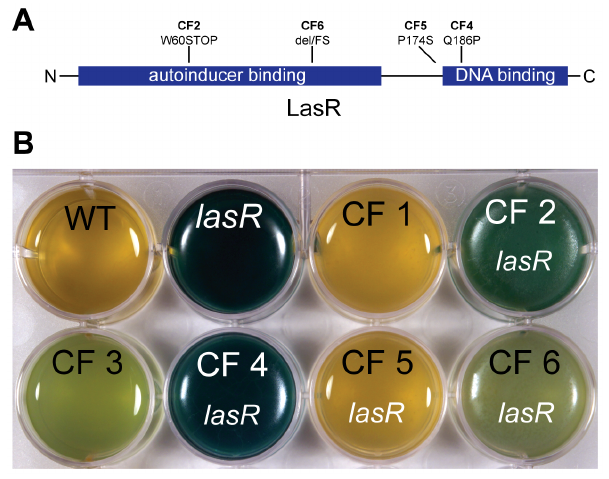
Figure 6. Clinical lasR isolates can overproduce pyocyanin. A. Locations of mutations in the LasR protein detected by sequencing. The mutations are in clinical isolates from Ref. 17. B. Appearance of static LB cultures of PA14 and lasR laboratory strains and of clinical isolates (CF1- 6) [17] with and without lasR mutations. The cultures were grown for 12 days at 25 u C to allow weaker phenotypes to